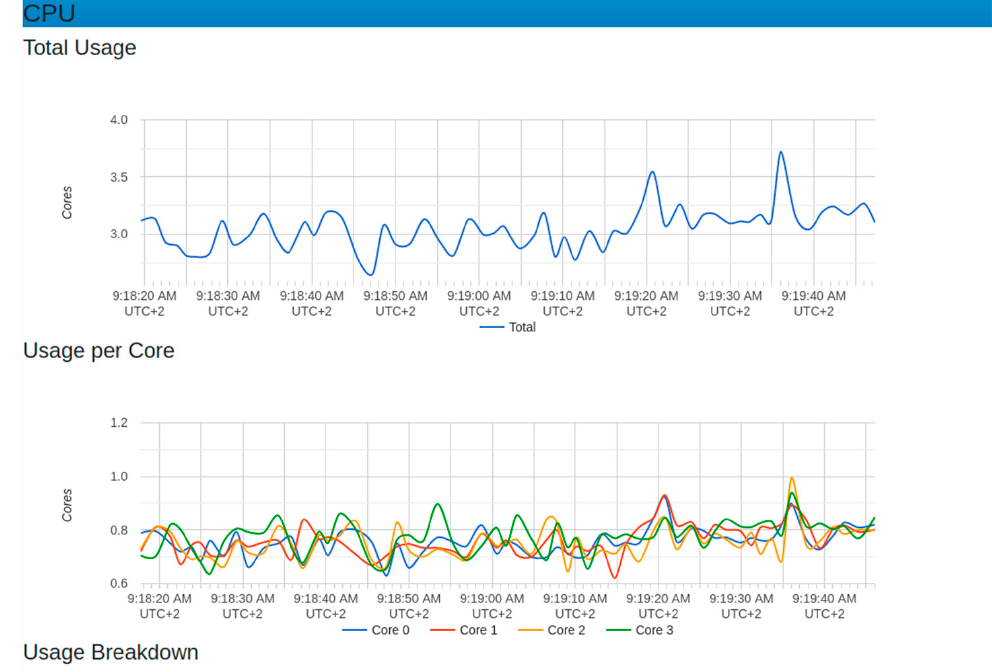
Figure 17. CPU resource with 1,000,000 generated sensor requests.